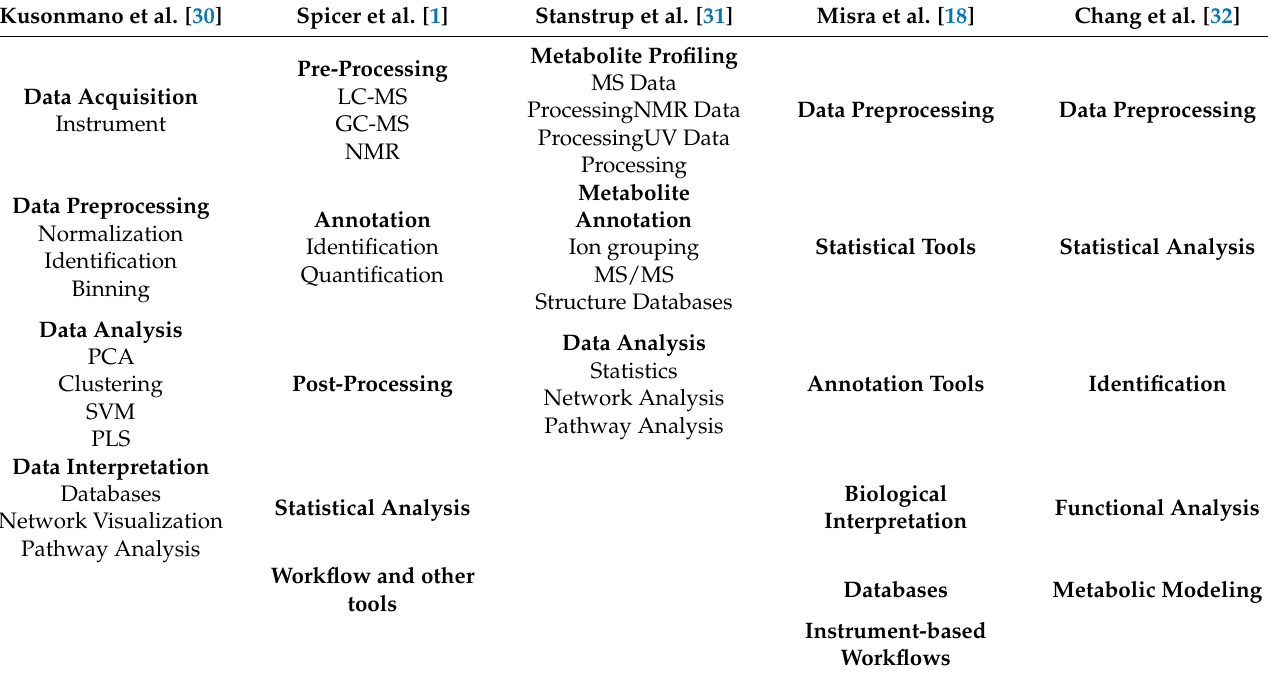
Table 1. Categorization (rows) of metabolomics software tools in previous surveys